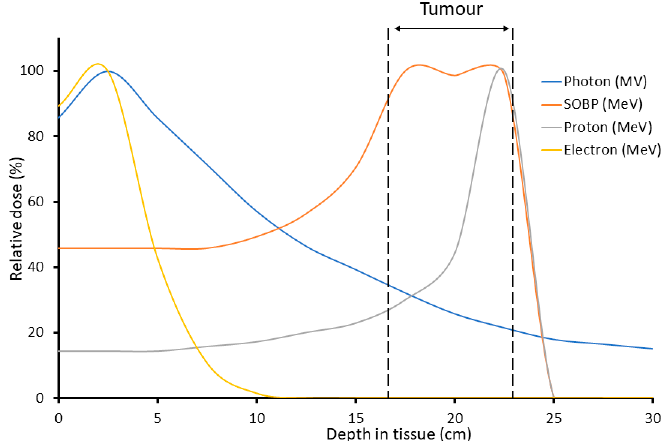
Figure 1. Comparison of depth–dose distribution of photons, protons, and electrons relative to a target tumor. A spread-out Bragg peak (SOBP) from several modulated proton beams is also shown, but which demonstrates the precise targeting of the tumor using PBT.